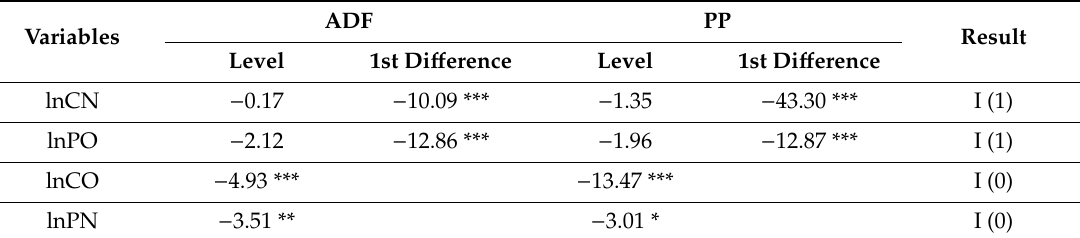
Table 2. Results of unit root test.